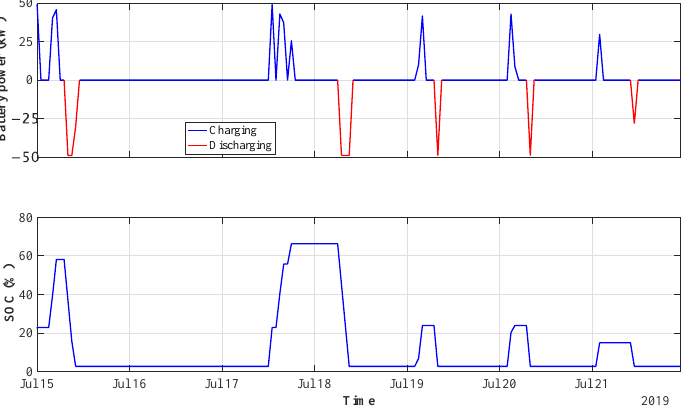
Figure 7. Optimal battery operation.